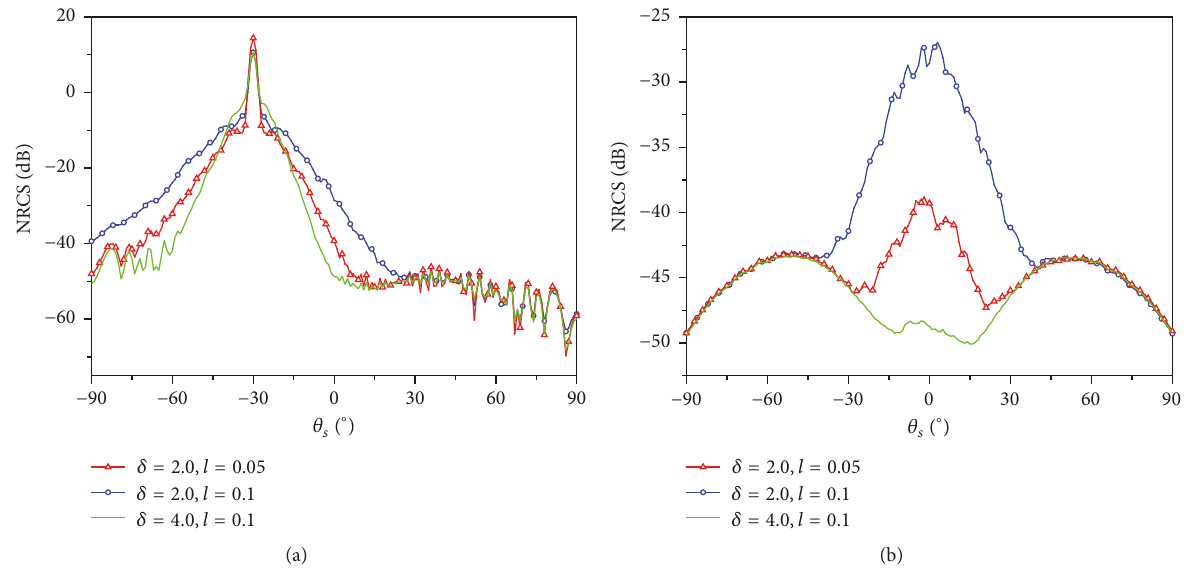
Figure 6: Scattering results of a 3D inhomogeneous sphere buried under dielectric rough surface with different 𝛿 and 𝑙 : (a) 𝑋 - 𝑍 Plane and (b) 𝑌 - 𝑍